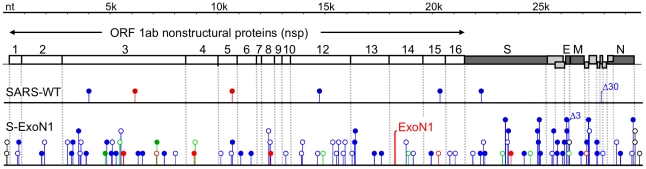
Distribution of mutations across genomes of aggregate viral clones.Combined mutations from 10 SARS-WT and 10 S-ExoN1 P3 viral clones are plotted according to position in the SARS-CoV genome (drawn to scale). Non-engineered mutations are depicted as lollipops and engineered ExoN1 mutations in nsp14 are depicted as a bent vertical line. Red, mutations common to all SARS-WT or all S-ExoN1 clones; green, mutations common to multiple but not all S-ExoN1 clones; blue, mutations unique to one SARS-WT or S-ExoN1 clone. Filled lollipops, nonsynonymous mutations; open lollipops, synonymous mutations; black open lollipops, mutations in non-coding regions. A 30-nt deletion in SARS-WT clone 7 that disrupts ORFs 8a and 8b and a three-nt deletion identified in S-ExoN1 clone 46 in ORF E are indicated above the lollipops by Δ30 and Δ3, respectively. All mutations identified in SARS-WT genomes occurred at nucleotide positions distinct from those in S-ExoN1 genomes. White boxes, nsp domains encoded by ORF1. For simplicity and because no mutations were detected in nsp11, a predicted 17-aa polypeptide that partly overlaps with the amino-terminus of nsp12, nsp11 is not shown. Dark gray boxes, ORFs encoding structural proteins: S, Spike attachment glycoprotein; E, Envelope protein; M, Membrane protein; N, Nucleocapsid protein. Light gray boxes, ORFs encoding group-specific (accessory) proteins.